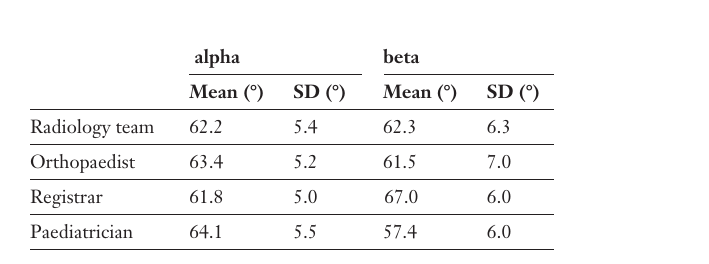
Inter-observer agree- ment: proportion of agreement (italic) positive and negative index of proportional agreement (normal) ; kappa value and 95% kappa confidence interval (bold) of the four groups of obser- vers on the dichoto- mous classification normal vs. abnormal.